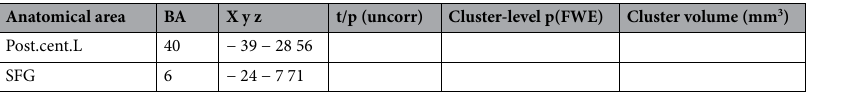
Table 2. Peak activations and anatomical areas of the interaction-contrast analyses (reflecting diversity) among all four EF tasks. All resulting t-maps were thresholded at a voxel-level p < 0.005 (uncorrected) and only clusters significant at p < 0.05 (FWE corrected) were